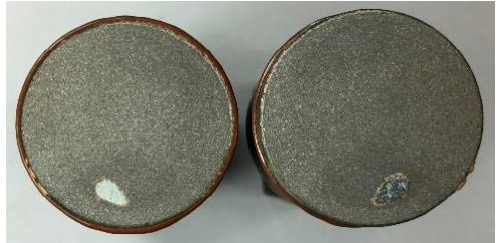
Figure 4. Photograph of the fracture section of the composite coating.